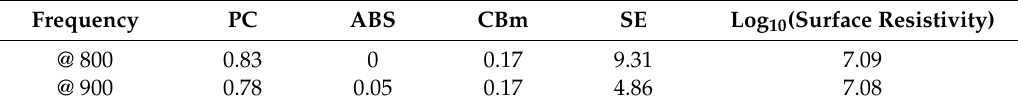
Table 3. Optimized mixing ratio among PC, ABS, and CBp.